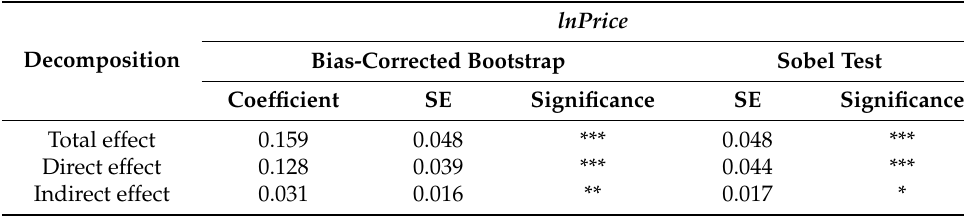
Table 7. Decomposition of effects of COCLEM on SIL transaction